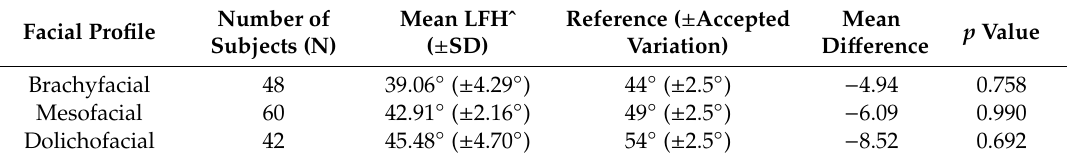
Table 2. Correlation between LFHˆ and OVD for di ff erent pattern of growth of the enrolled participants, classified according to MLˆFH